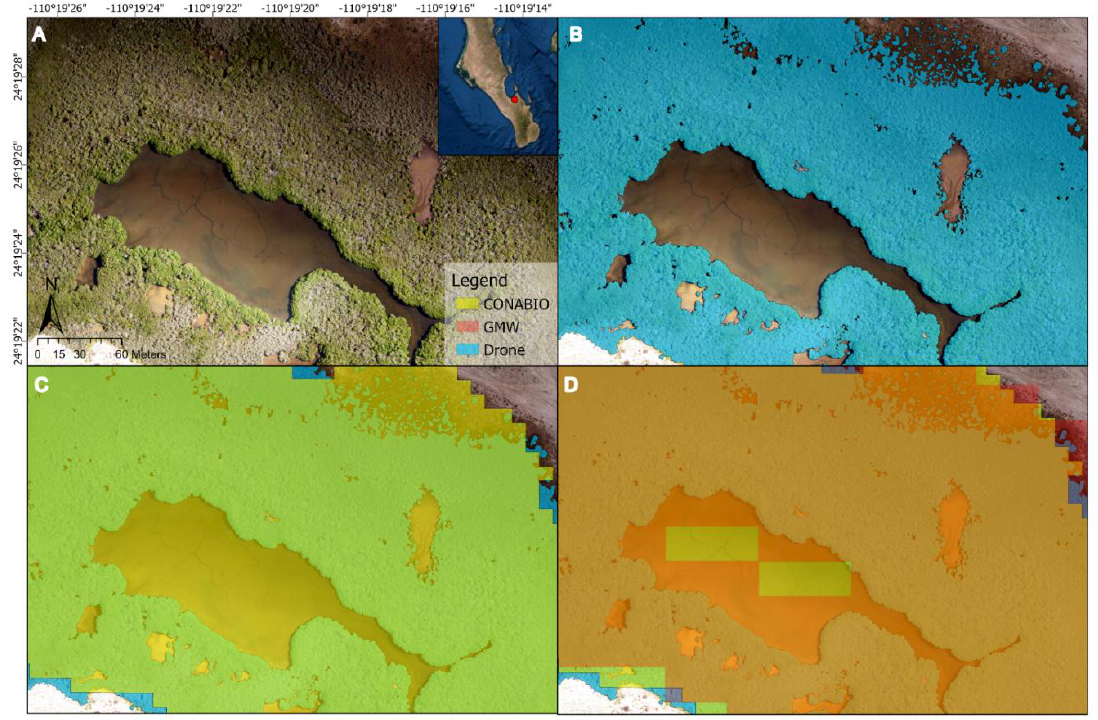
Figure 5. Comparison between mangroves, using ( A ) drone imagery of Balandra in La Paz, Baja California Sur (BCS), in July 2019, and ( B ) mangroves manually classified from drone images, ( C ) mangroves identified by CONABIO, and ( D ) mangroves identified by GMW overlaid on top of the drone imagery. Both CONABIO and GMW datasets overestimate a large lagoon and smaller patches of dirt and water at this site.